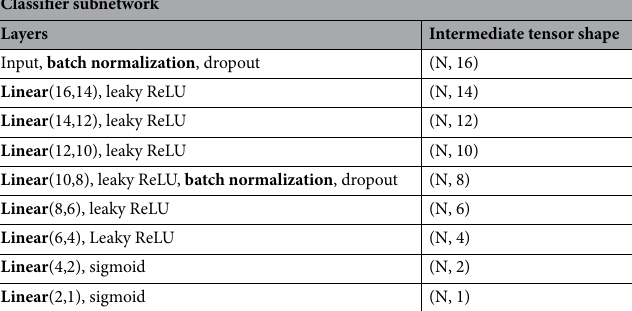
Table 3. Classifier subnetwork parameters. This classifier subnetwork is used in all neural networks with the same parameters. Dropout was adjusted to prevent overfitting for each. N is the batch number of the input tensor. Trainable layers are given in